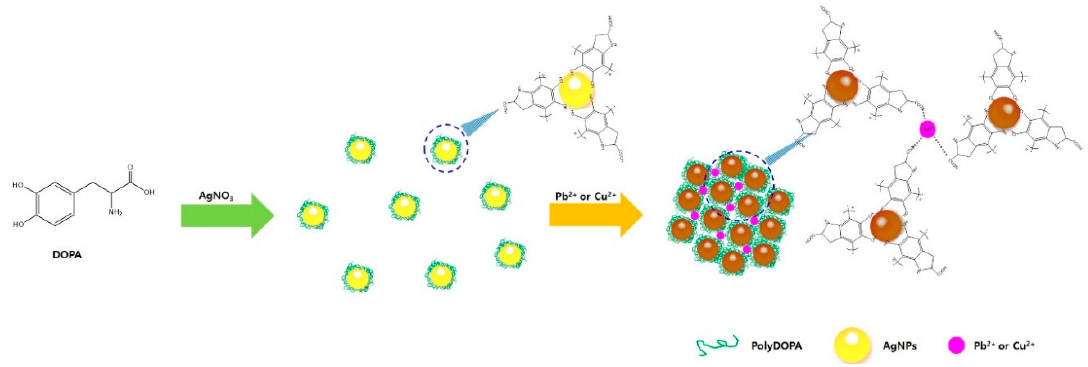
Figure 7. Schematic illustration of mechanism of colorimetric detection of Pb 2+ and Cu 2+ ions with polyDOPA-AgNP. Table 2. Results of Pb 2+ and Cu 2+ detection in water samples.